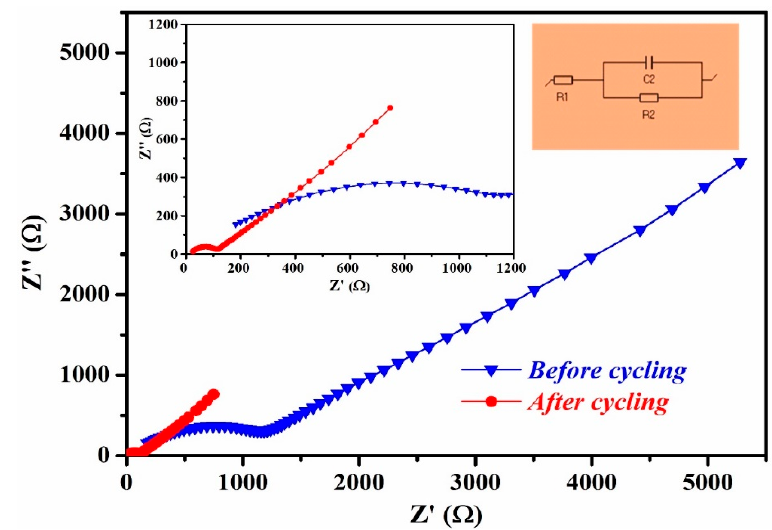
Figure 6. Niquist plots for sheet-like ZnCo 2 O 4 before and after 1000 cycles. Inset shows the magnified images for sheet-like ZnCo 2 O 4 and fit circuit diagram ( R 1 —the series resistance ( R s ), R 2 —the charge transfer resistance ( R ct ) and C 2 —the constant phase element of the circuit.). Table 5. Series resistance ( R s ) and charge transfer resistance ( R ct ) of sheet-like ZnCo 2 O 4 before and after cycling. Resistance Before Cycling After Cycling ( Ω ) 242.2